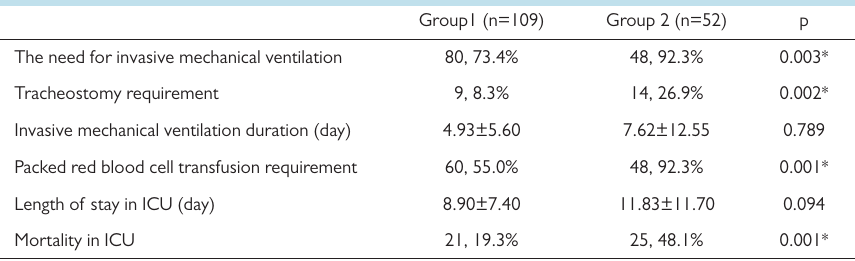
Table 3. Intensive care unit management and outcomes of the patient